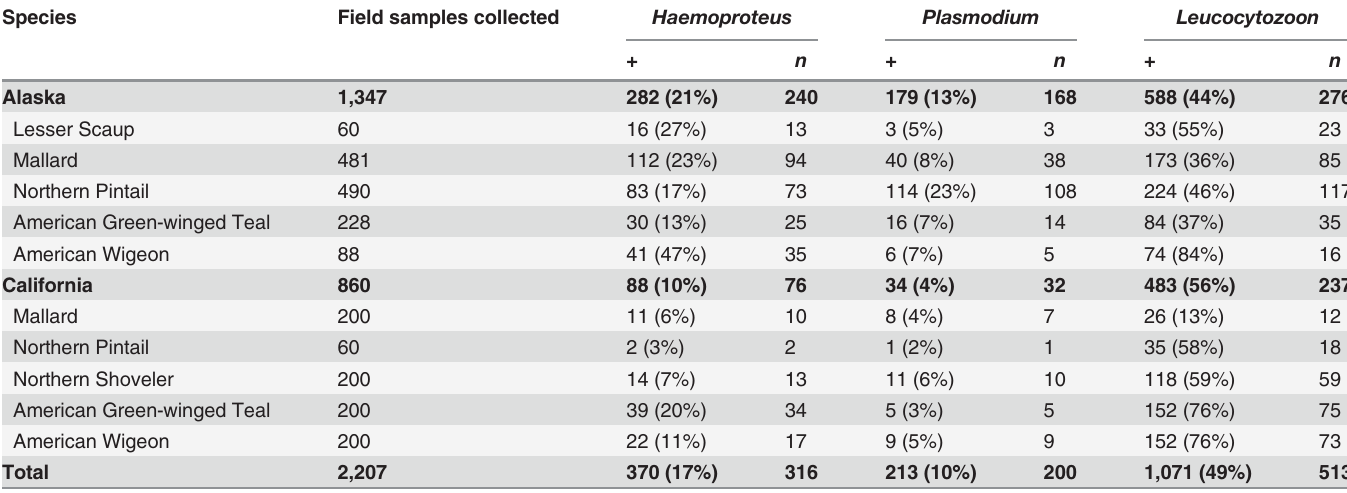
Table 1. Summary of fi eld samples collected by location and species, the number of con fi rmed positive infections (+), the percentage of samples identi fi ed as positive (in parentheses), and the corresponding number of sequences used ( n ) in diversity and phylogenetic analyses (i. e. sequences used = the number of sequences with bi-directional coverage of 386 base pairs and no ambiguous bases) are indicated. Species Field samples